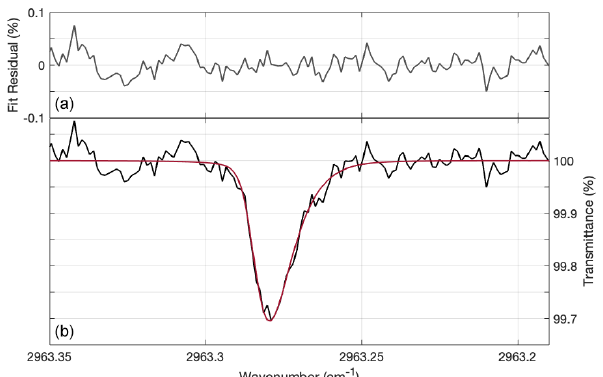
Figure 9. Example of a 30s spectrum from flight, focused on the region that was used to determine HCl mixing ratios. The spec- trum corresponds to 1.19ppbv HCl at a cell pressure of 13.6hPa. (b) The black line is the detrended spectrum, and the red line is the fit. (a) The fit residual, which equals detrended spectrum–fit, is shown in dark grey. The absolute residual averages to 0.016% in this